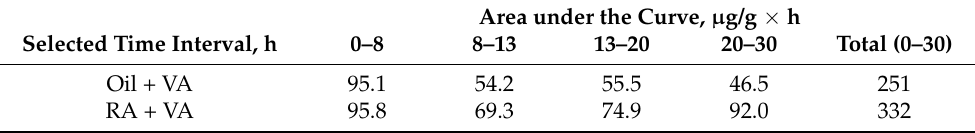
Table 1. Area under the curve (AUC) in RA-pretreated pups and CN pups, indicating higher intestinal VA mass accumulation in RA-primed pups in the later hours after VA